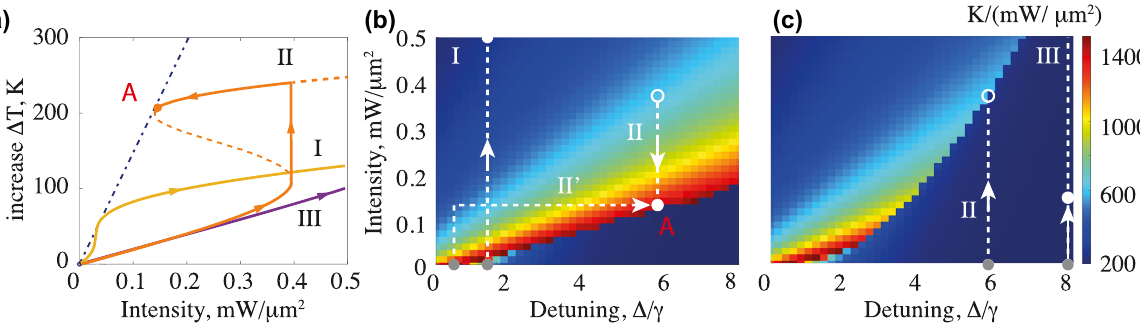
Figure 4: Numerical simulations of bistability behavior in single optical resonator. (a) The dependence of the temperature on the pump intensity for different detuning parameters Δ 𝜔 ∕ 𝛾 = 1.5 (I), Δ 𝜔 ∕ 𝛾 = 6 (II), Δ 𝜔 ∕ 𝛾 = 8 (III). (b) and (c) Heating efficiency maps Δ T ∕ I 885 nm, as the function of pump intensity I difference in the maps denotes hysteresis